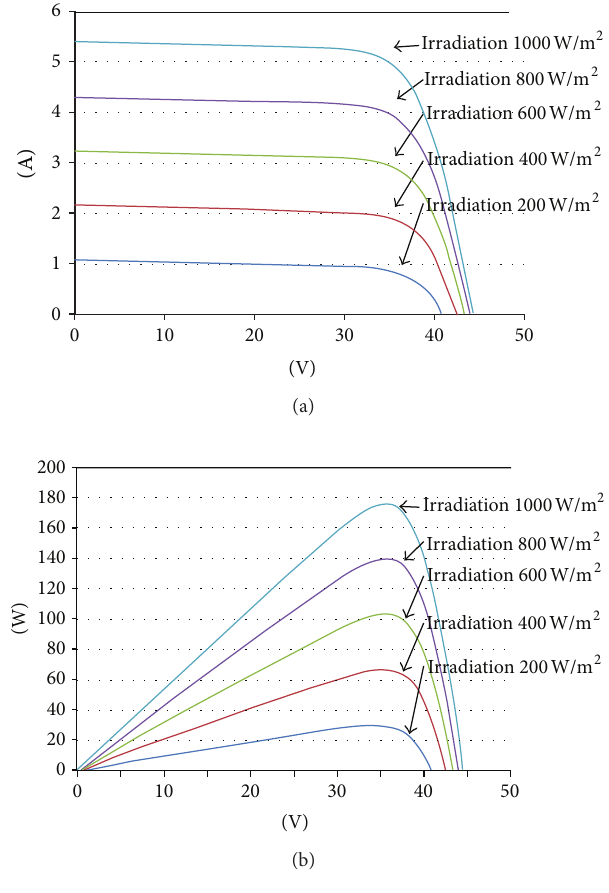
Figure 3: The simulated I-V and P-V curves of the SHARP NT- R5E3E photovoltaic power module using Solar Pro software with an irradiation between 200 and 1,000W/m 2 and a PV module surface temperature less than 25 ∘ C; (a) I-V curve and (b) P-V curve.